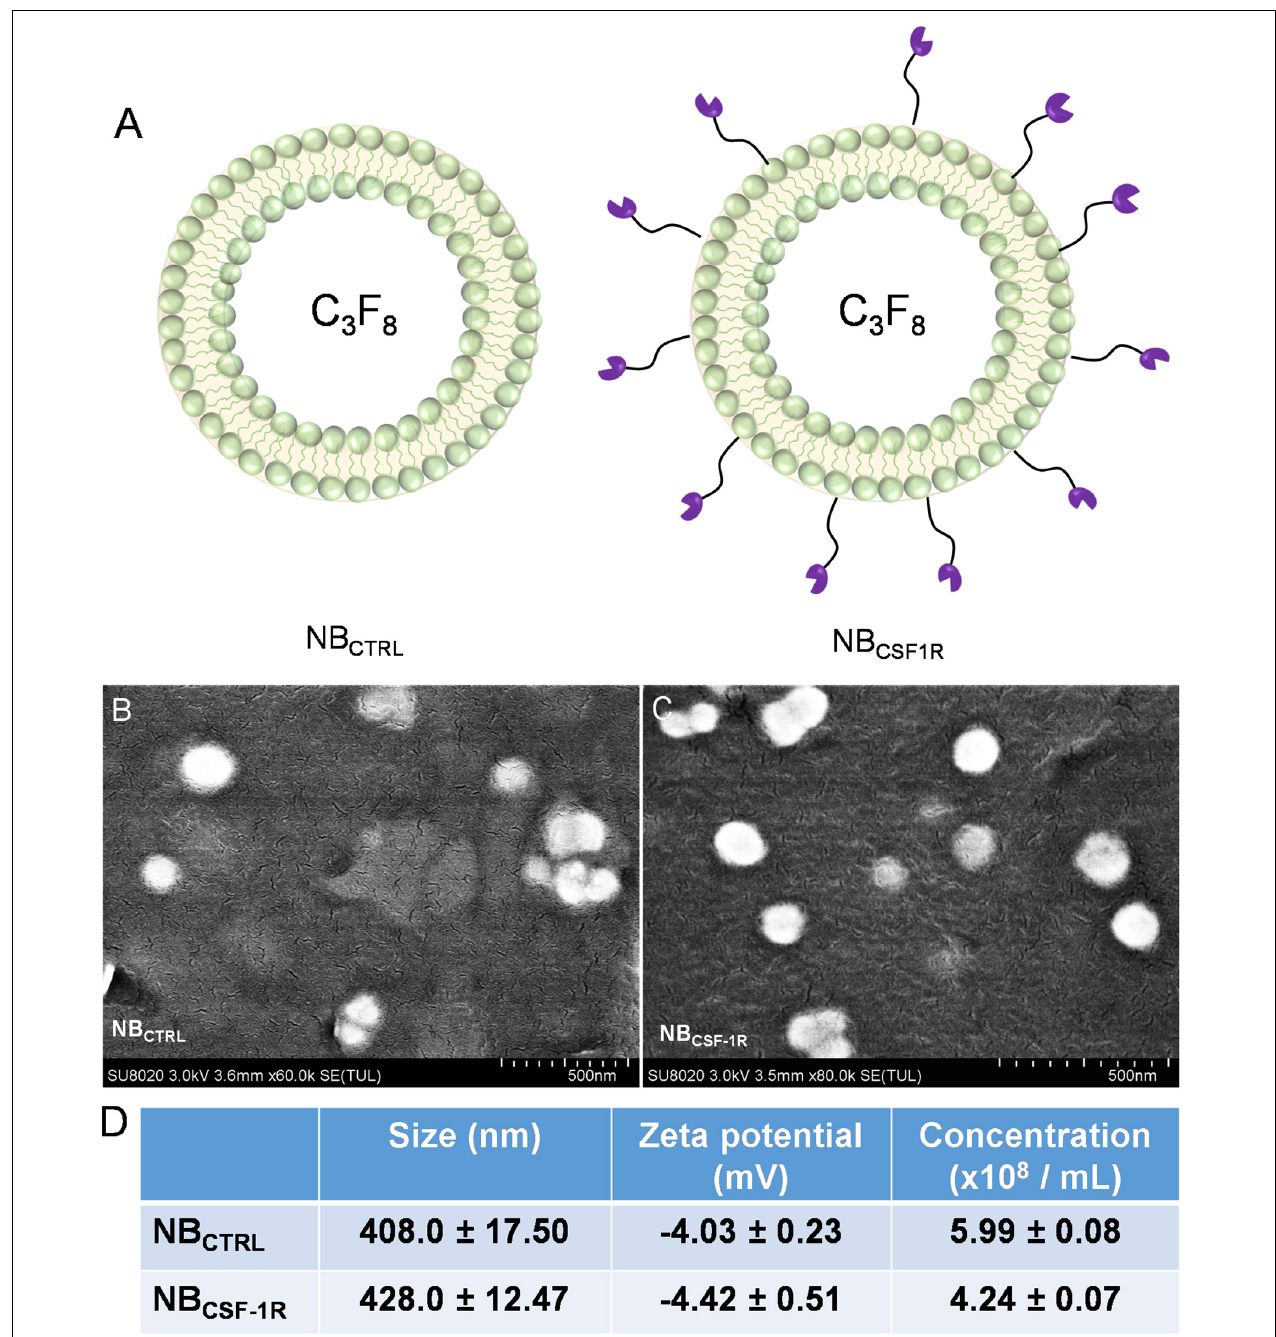
FIGURE 3 | (A) Showed the structure of the NB CTRL and NB CSF − 1R , (B) scanning electron microscopy (SEM) image of NB CTRL with a scale bar of 500 nm (C) SEM image of NB CSF − 1R with a scale bar of 500 nm. (D) Summary of the average size, and zeta potential of NB CTRL and NB CSF − 1R as measured by dynamic laser scattering. Concentration of NBs were measured by Coulter counter. Data represent mean ± SD ( n = 5).